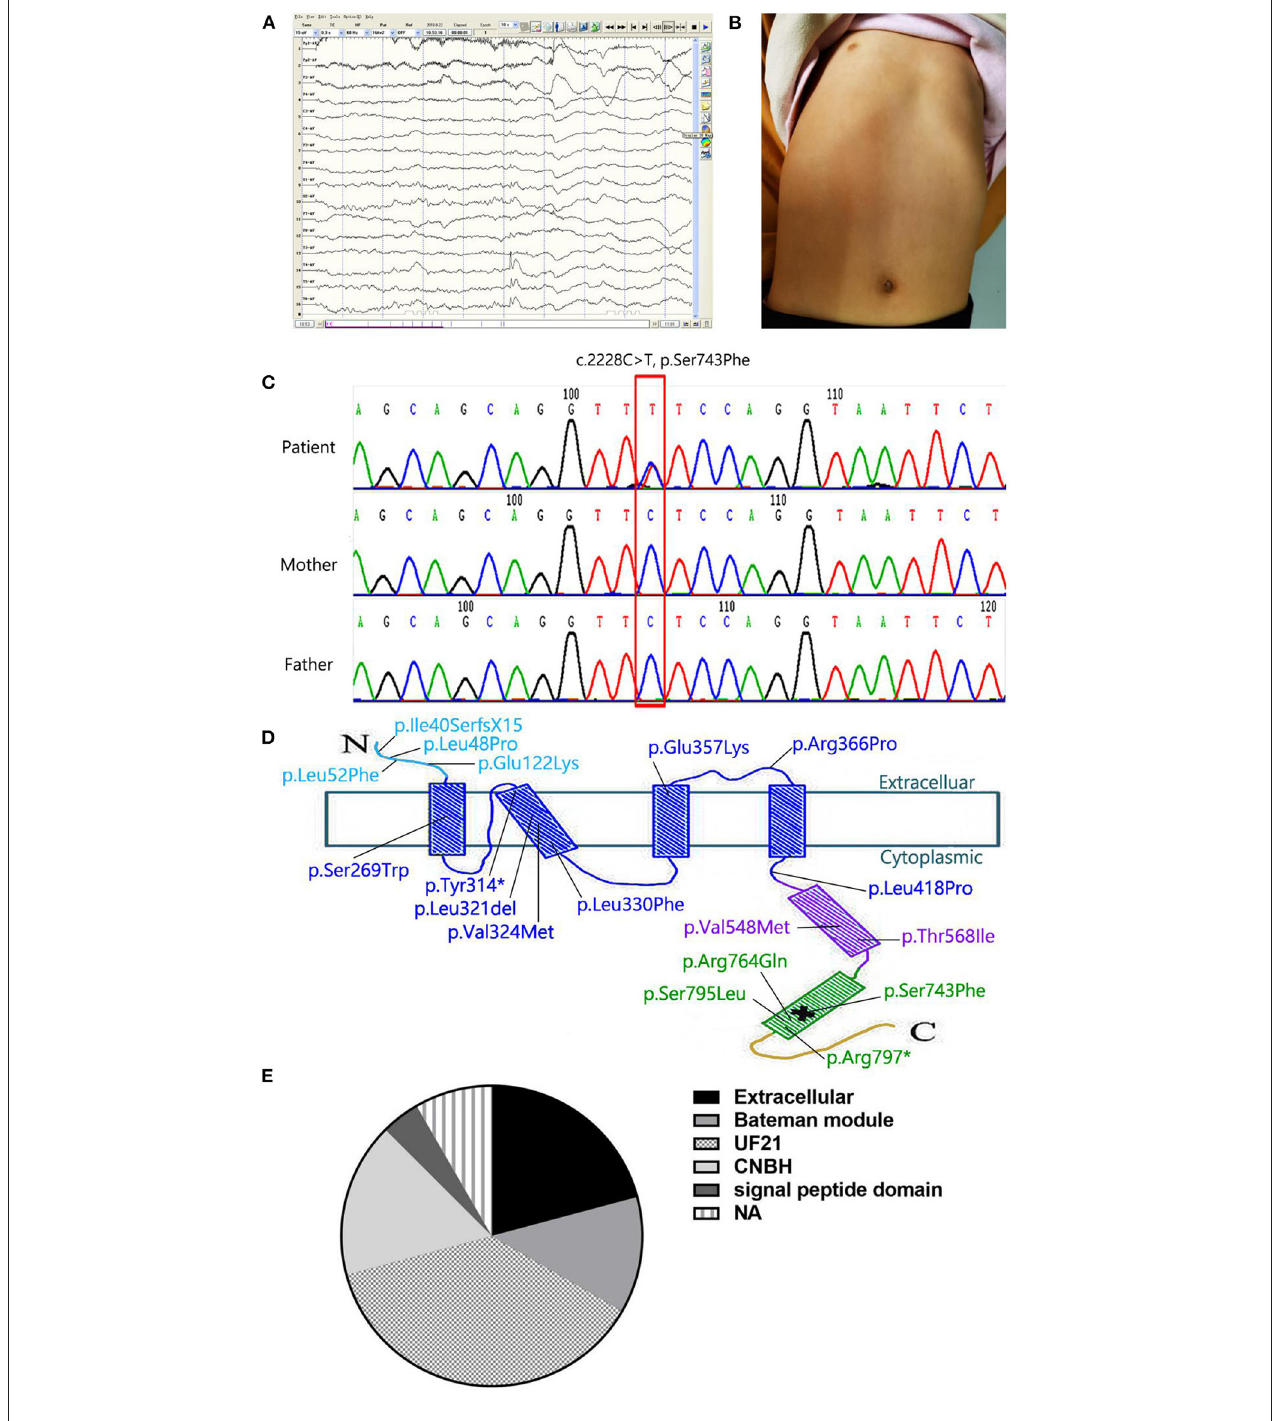
FIGURE 1 | (A) The EEG monitoring showed the release of sharp-slow and spinous-slow waves in the left posterior temporal region and the right middle posterior temporal regions. (B) Patient’s picture showing a funnel-shaped chest. (C) Partial CNNM2 electropherograms of the patient and her parents. In the electropherograms, the variant is indicated by a red box and the changes in nucleotide and resulting effects on the protein are shown. (D) Localization of the variant in the secondary structure of CNNM2. The N-terminal extracellular domain and the transmembrane domain are in light blue and dark blue respectively. The CBS domain is in purple, the CNBH domain is in green, and the unstructured C-terminus is yellow. *means stop codon. The location of pathological variant is indicated by a cross. (E) variant domains of cases listed in Table 1 . In 24 cases, we found 5 domains: extracellular (5/24), bateman module (3/24), UF21(9/24), CNBH(4/24), and signal peptide(1/24). The other two cases were not available